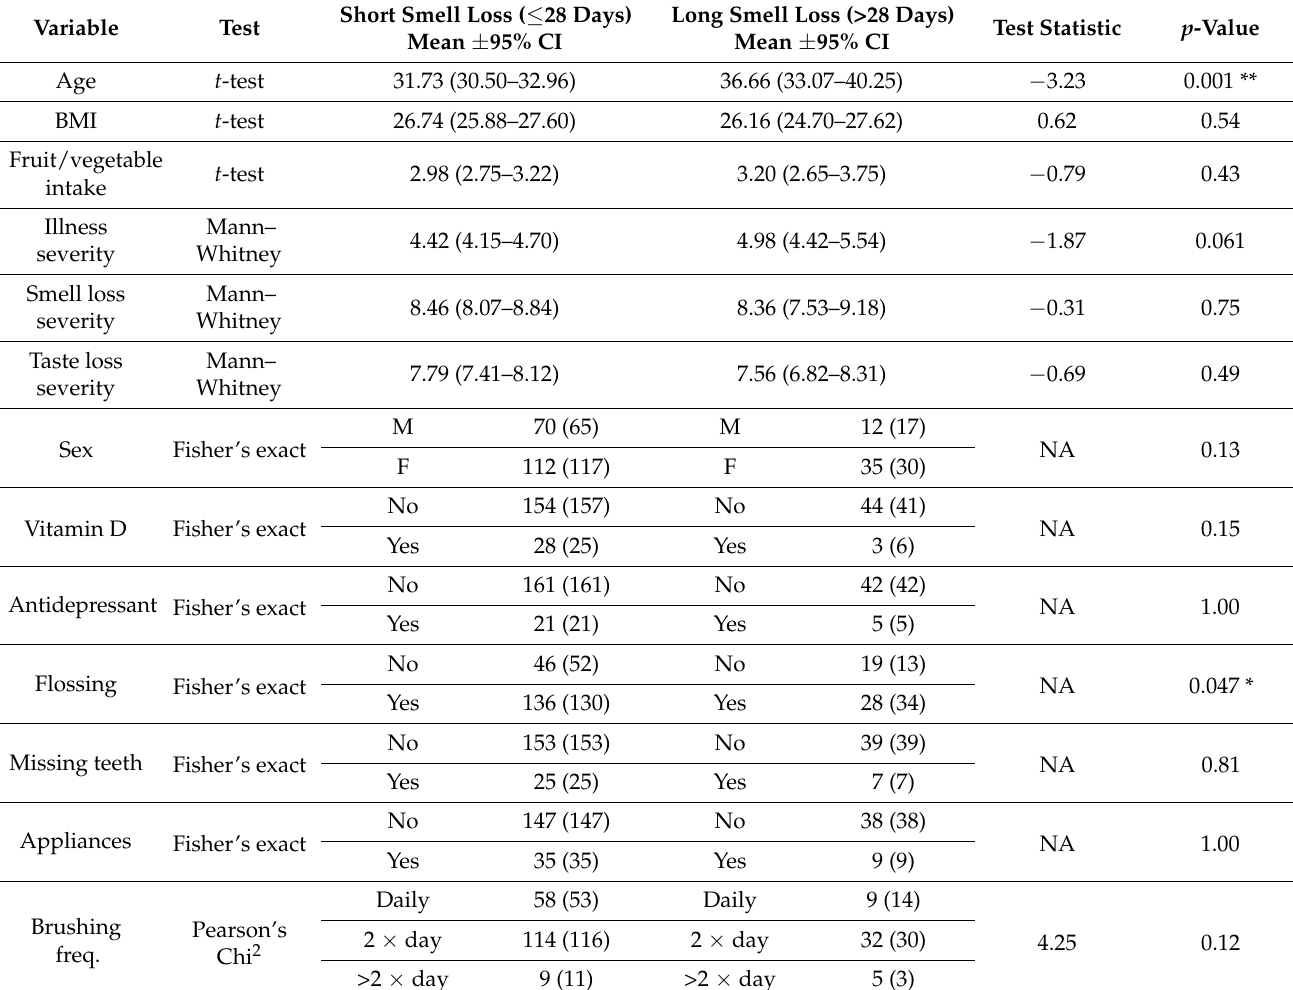
Table 1. Comparison of short ( ≤ 28 days) and long (>28 days) taste loss. For Fisher’s exact test and Chi 2 test observed values are shown followed by expected values in brackets. *—significant at p < 0.05, **—significant at p <